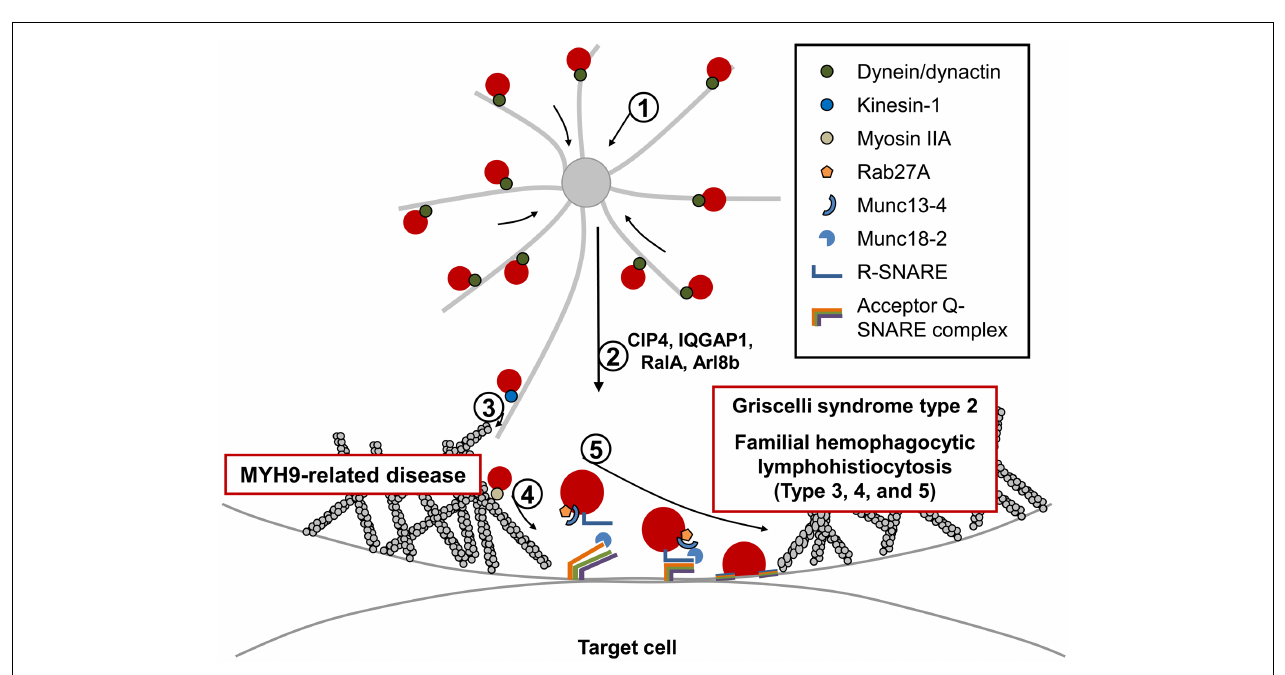
final transit of the lytic granules through the hypodense F-actin meshwork at the CS. NK cells from patients with MYH9-related diseases fail to degranulate. (5)The final fusion of lytic granules with the plasma membrane occurs in an orchestrated manner and requires multiple molecules including Rab27a, its effector protein Munc13-4, SNARE proteins, and their accessory proteins. Mutations in proteins involved in this final fusion step have been found to cause immunodeficiency disorders including Griscelli syndrome type 2, familial hemophagocytic lymphohistiocytosis types 3, 4, and 5, all of which have similar clinical symptoms, and defective lytic granule